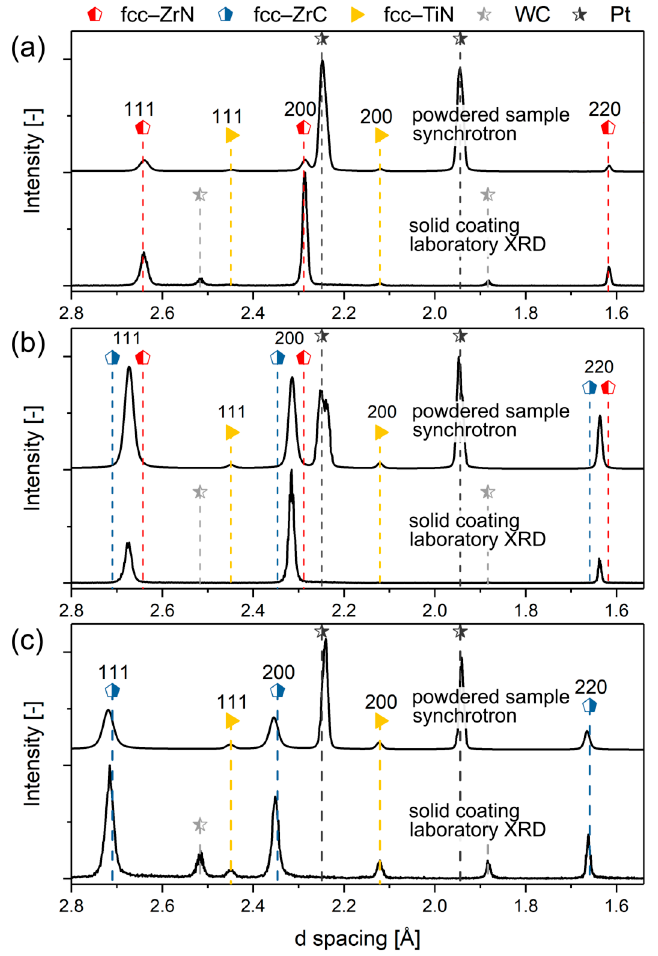
1 Figure 2. Comparison of the X-ray diffractograms of the solid coatings (laboratory XRD in grazing incidence geometry with 2 ◦ incidence angle) and the powdered coatings (synchrotron radiation facility, Debye-Scherrer geometry) for the ( a ) ZrN, ( b ) ZrCN, ( c ) ZrC samples. The patterns were recorded at room